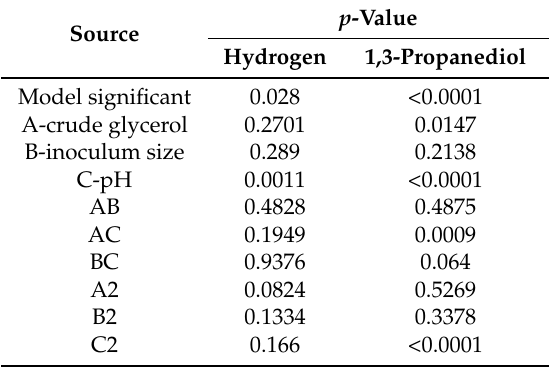
Table 3. The model ANOVA results for hydrogen production and 1,3-PD concentration. p Source